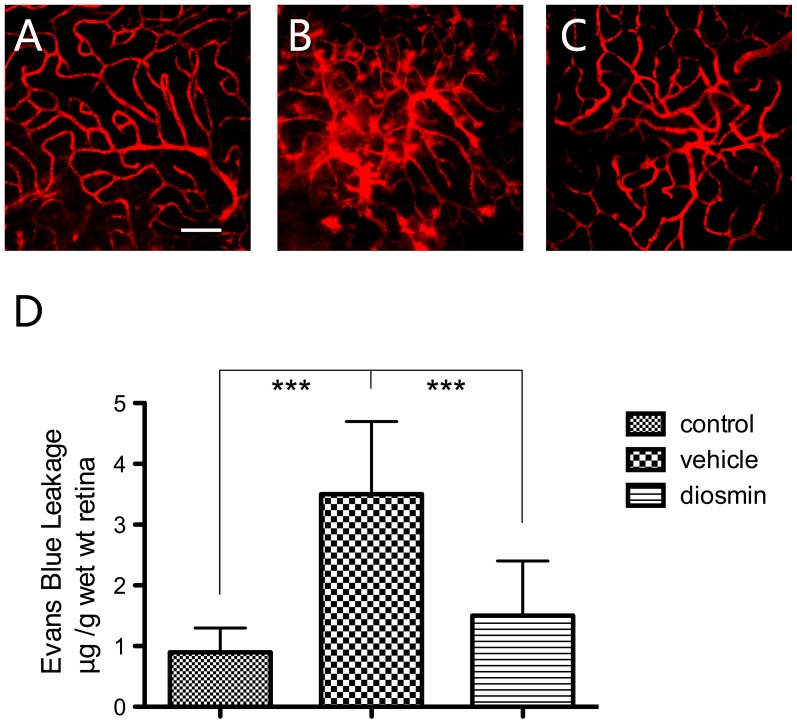
Visualization of retinal blood vessel leakage after intravascular perfusion with Evans Blue.(A) Low levels of background fluorescence and vasculature sharply outlined by the dye are seen in control retinas. (B) Twenty-four hours after ischemia, focal sites of leakage and diffusely distributed dye are found in the vehicle retinas. (C) Diosmin treatment markedly reduced the vascular permeability. (D) Quantitative analysis of the Evans Blue leakage. The photographs are representative of four eyes per group and the data are expressed as the mean±SD (n = 6). ***P<0.001. Scale bar = 100 µm.